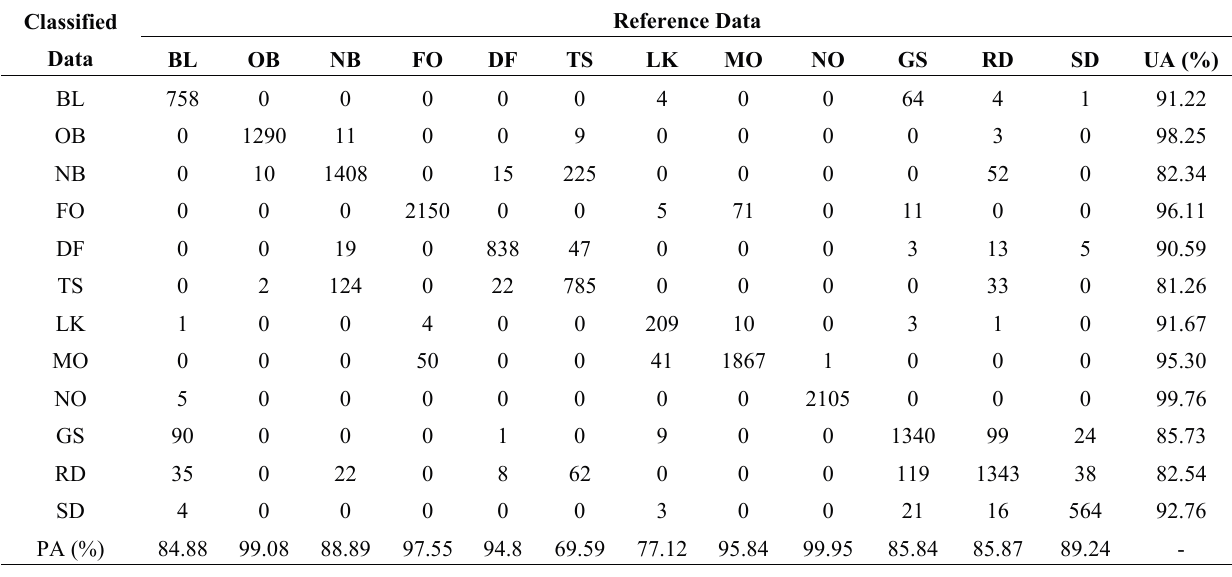
Table 4. Confusion Matrix of the Proposed Method (L-band).